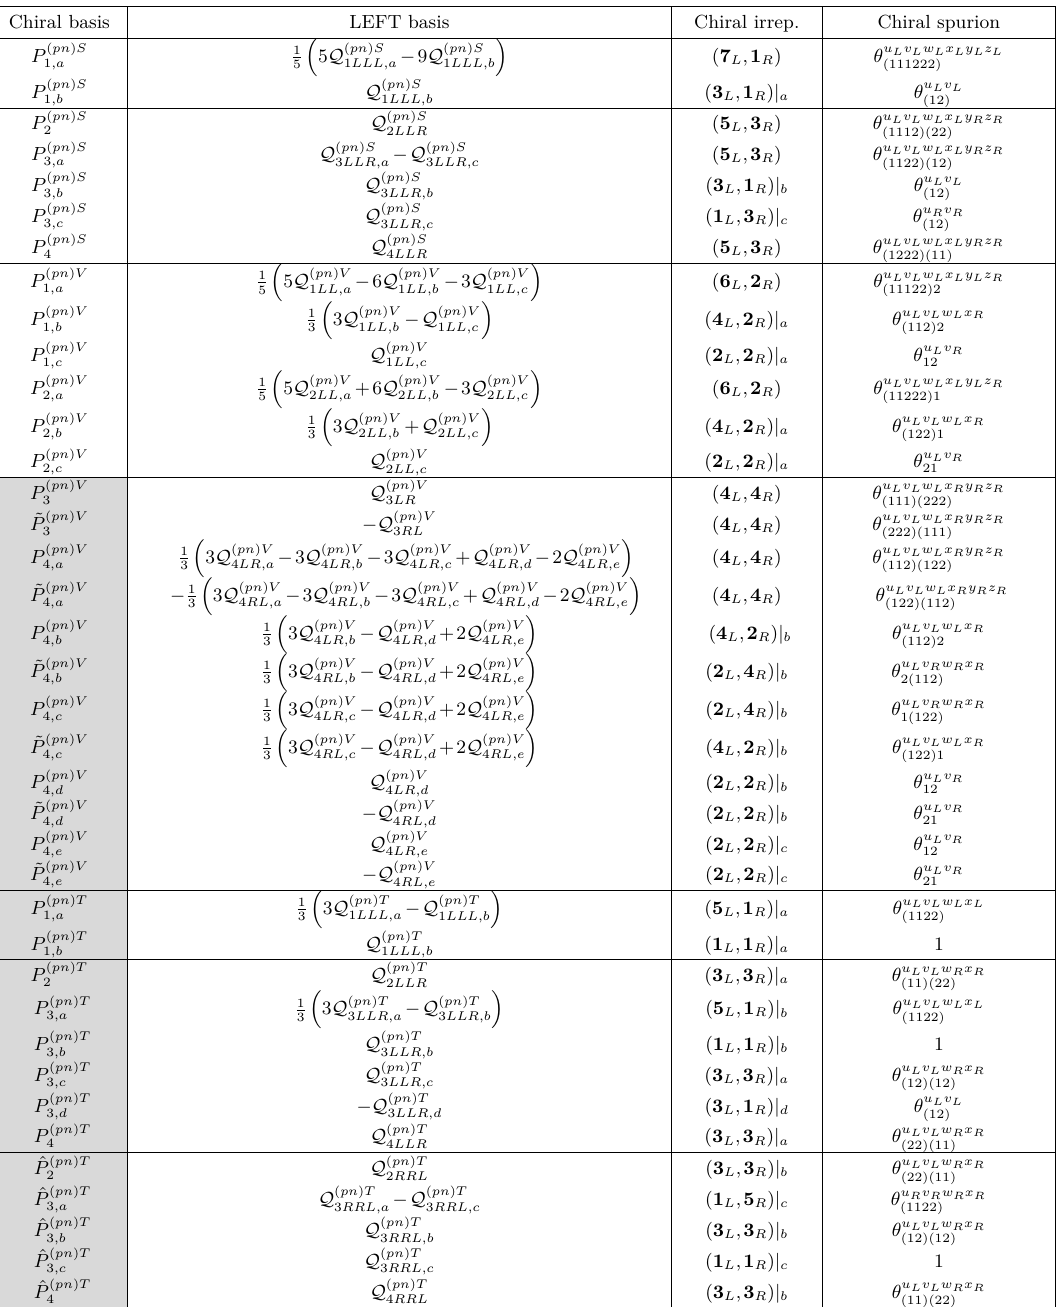
Table 6 . The chiral basis and their chiral irreps under G χ for the operators contributing to pn → ‘ + ¯ ν 0